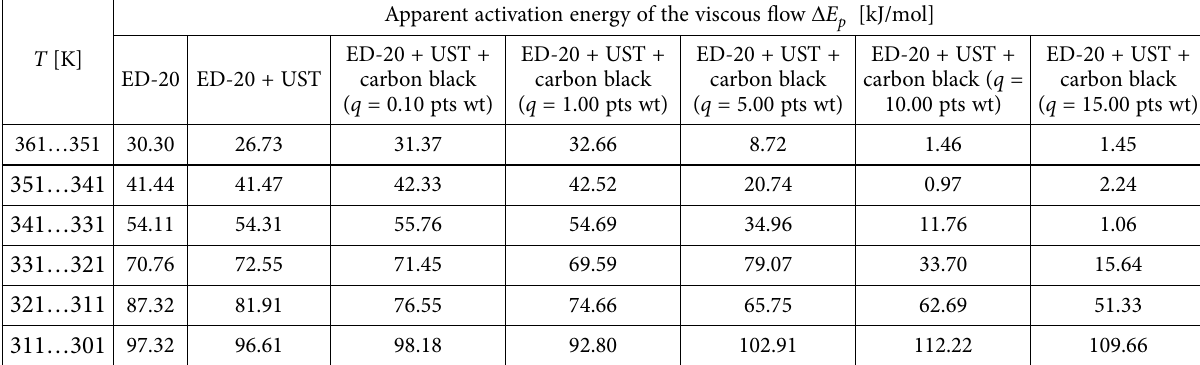
1.502.002.503.003.504.004.50 h l g Figure 2. Dependence of viscosity of the sonicated and non-sonicated epoxy resin ED-20 and compositions with nanodispersed soot on the test temperature Table 4. Values of the apparent activation energy of the viscous flow of compositions based on ED-20 resin at various filler concentrations Apparent activation energy of the viscous flow D E p [kJ/mol] ED-20 + UST + Т [K] ED-20 ED-20 + UST carbon